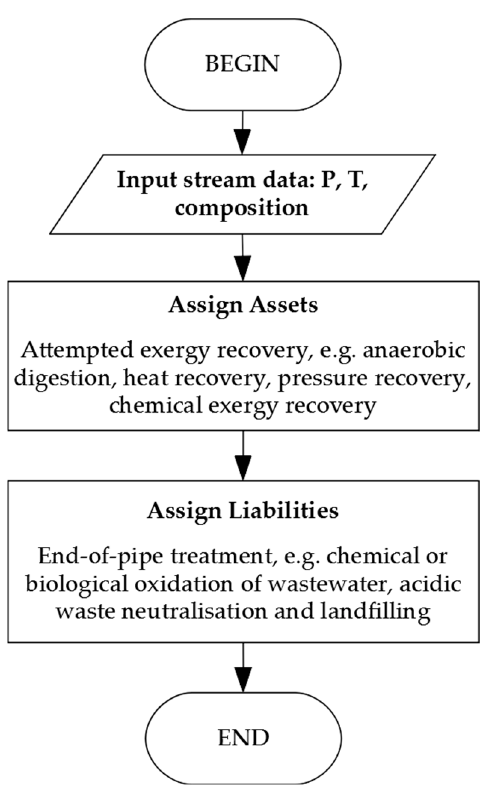
Figure 5. Procedure for assigning exergy assets and liabilities.